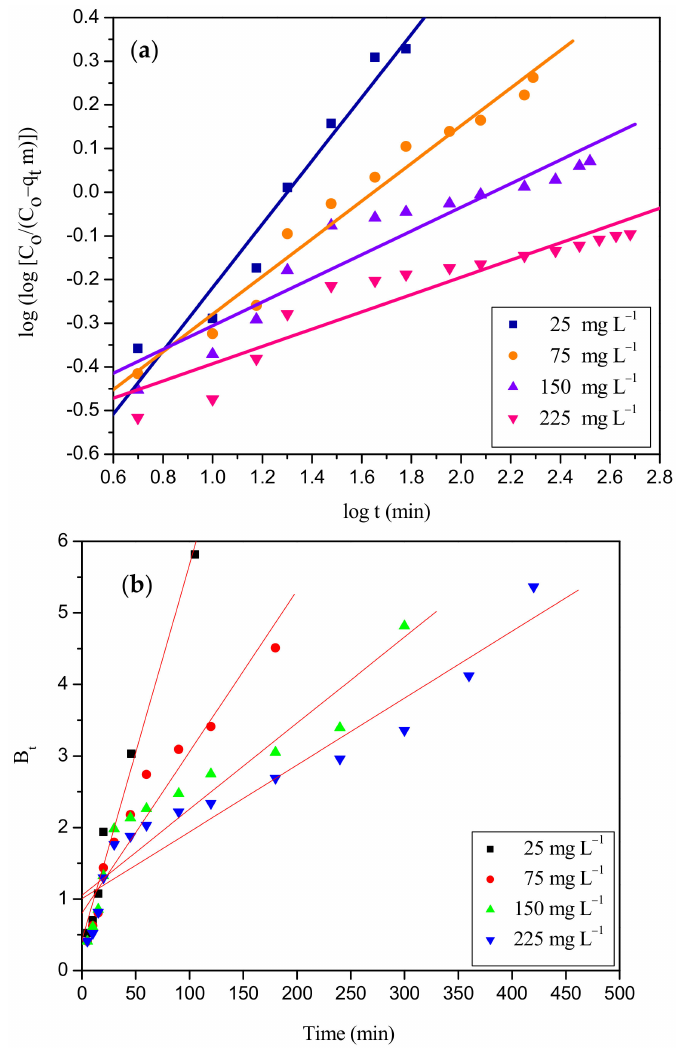
Figure 13. ( a ) Bangham and ( b ) Boyd plot for adsorption of RBBR dye onto WSBAC adsorbent. (Initial pH: 2; initial dye concentration: 25–225 mg L − 1 ; WSBAC adsorbent dosage: 6 g L − 1 ; adsorbent particle size: 55.21 µ m; agitation speed: 150 rpm; temperature: 301 K; contact time: 24 h). Inference from Thermodynamic Analysis for the Removal of